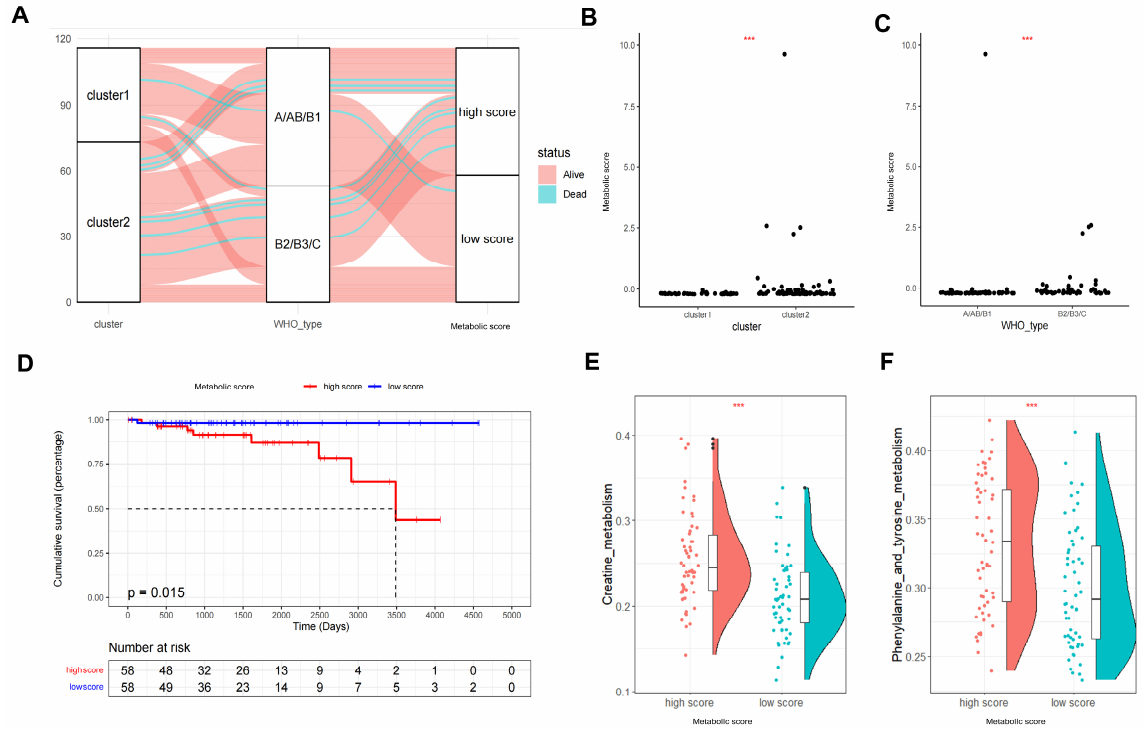
Figure 4. Construction of the metabolic score and exploration of the correlations of clinical features and biological pathways. ( A ) Alluvial diagram of groups in different TP-MRG clusters, WHO histological types, metabolic scores and survival status. ( B , C ) Differentiated metabolic scores between different TP-MRG clusters and WHO histological types (Wilcoxon test). ( D ) Kaplan–Meier curves for high- and low-metabolic-score groups of thymic epithelial tumors. ( E , F ) Raincloud plots showing the two differential metabolic pathways in high- and low-metabolic-score groups. *** p < 0.001.